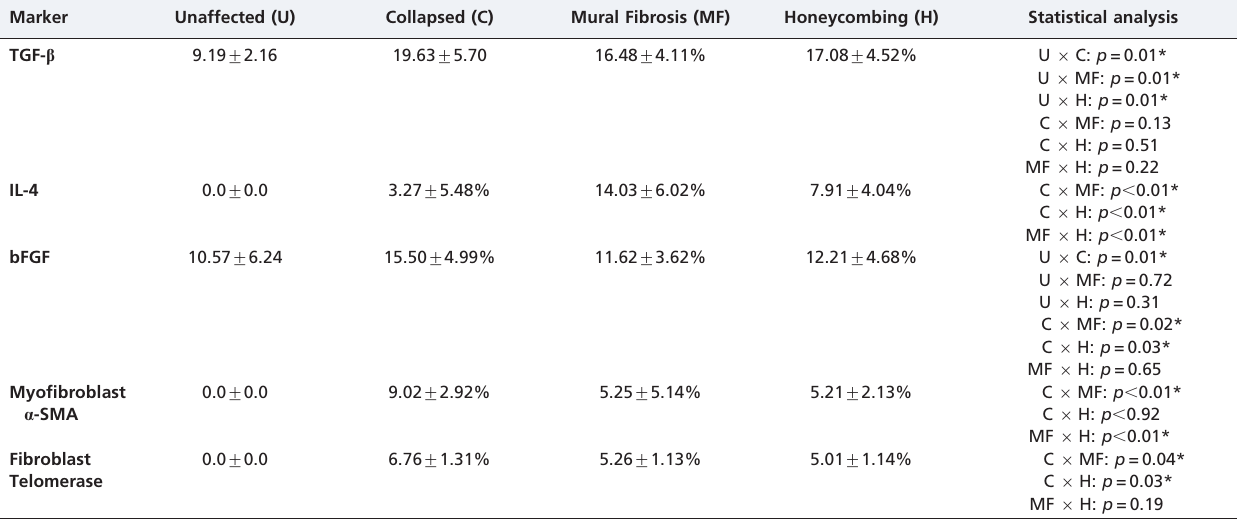
Table 1 - Mean levels of TGF- b , IL-4 and bFGF tissue expression and mean levels of myofibroblast a -SMA and fibroblast telomerase expression in each studied area. For tissue expression, all immunostained cells were considered to be positive. For fibroblasts expression, only immunostained cells with a morphological similarity to fibroblasts (thin cells with an elongated shape) were considered to be positive. Abbreviations: U, unaffected areas; C, collapsed areas; MF, mural fibrosis areas; and H, honeycombing